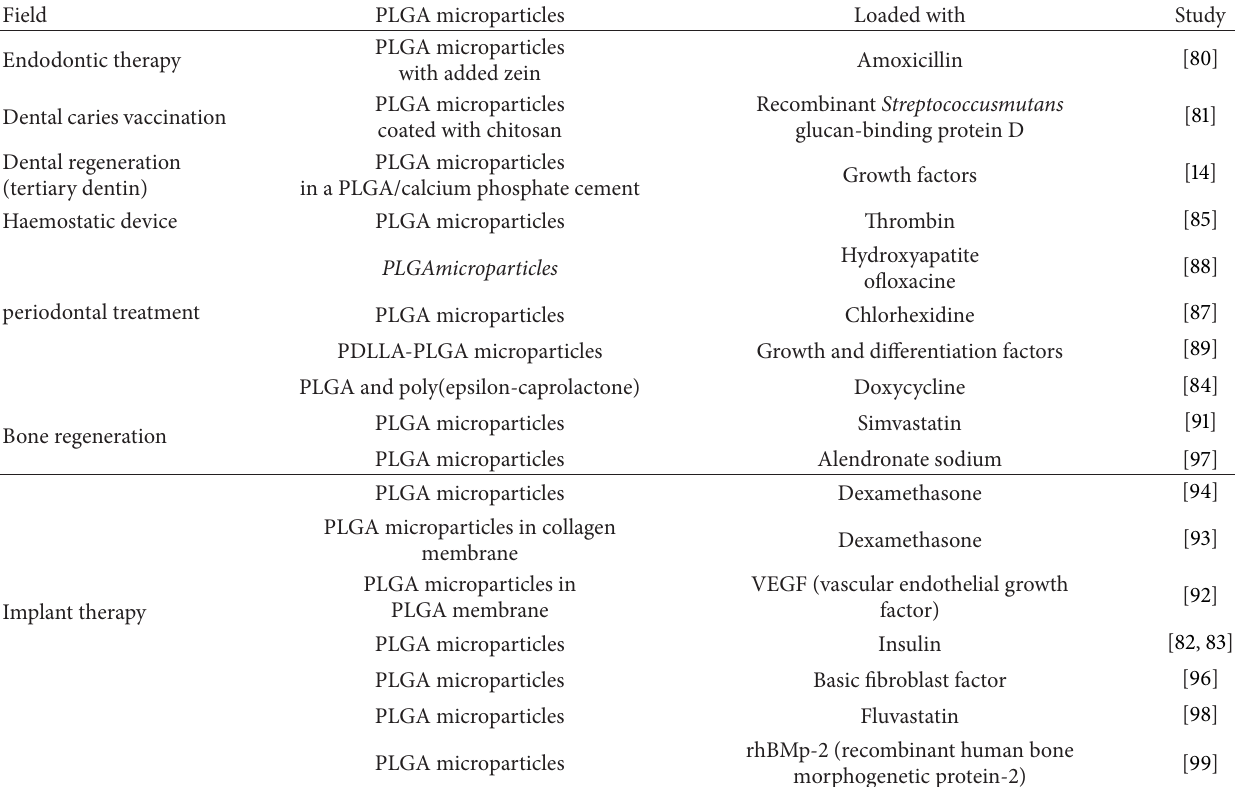
Table 4: Applications of PLGA microparticles in